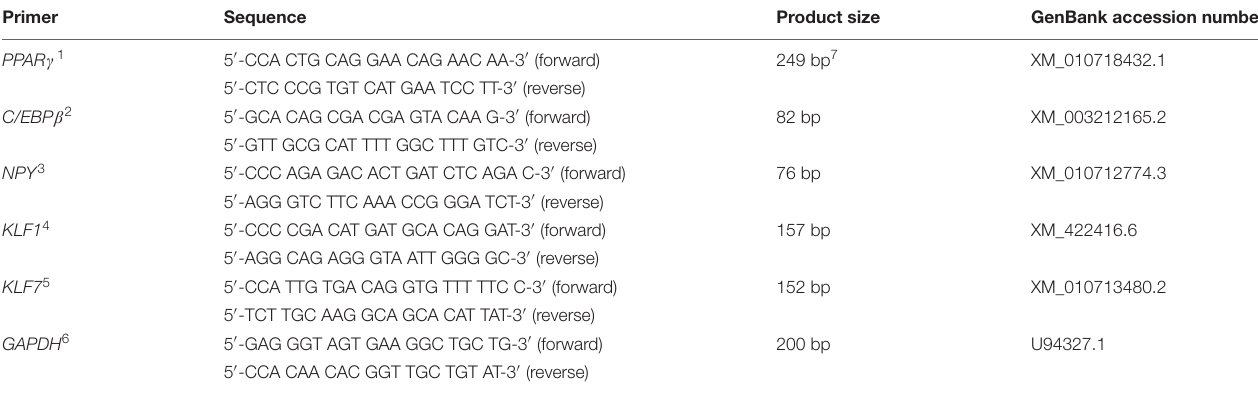
TABLE 2 | Primer sequences for real-time quantitative polymerase chain reaction.